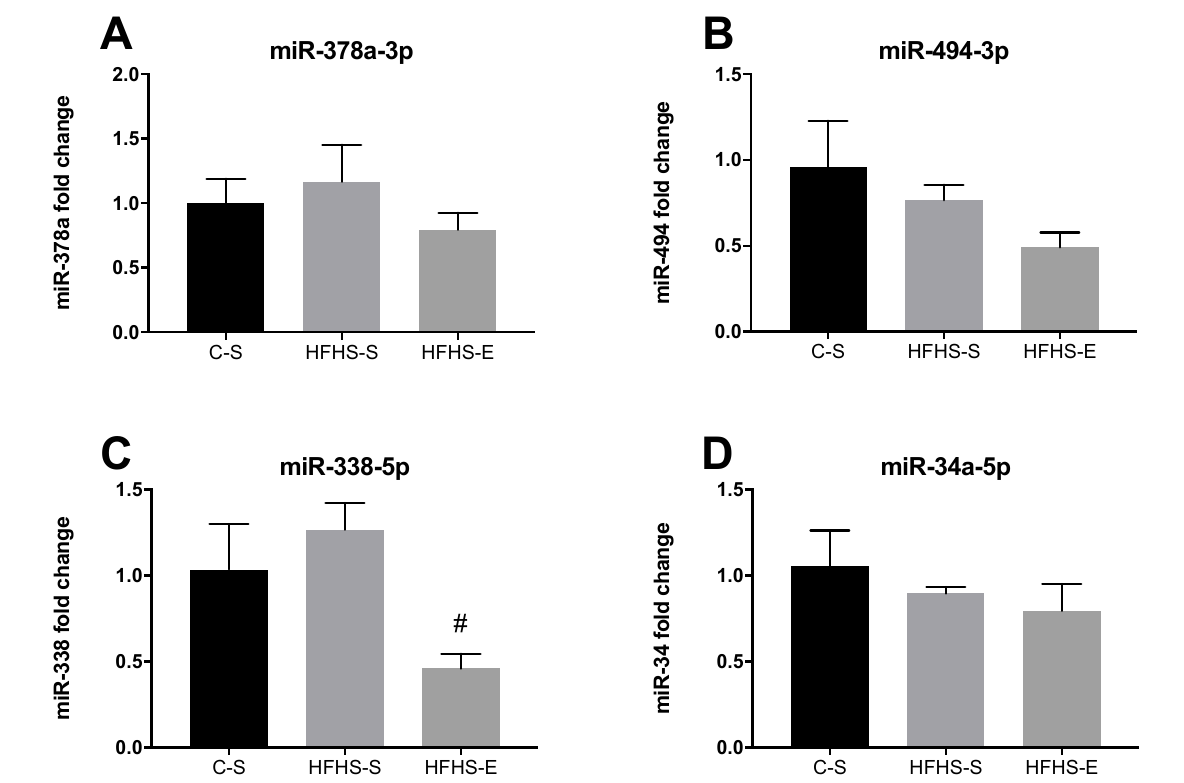
Figure 7. Expression levels of miR-378a-3p ( A ), miR-494-3p ( B ), miR-338-5p ( C ), and miR24a-5P ( D ) in the tibialis anterior. Offspring from the control diet sedentary group (C–S); offspring from the high-fat, high-sucrose diet sedentary group (HFHS–S); offspring from the high-fat, high-sucrose diet exercised group (HFHS–E), n = 6. Data are expressed as the mean ± SEM. Statistically significant differences ( p ≤ 0.05) are indicated as follows: # vs. HFHS–S.